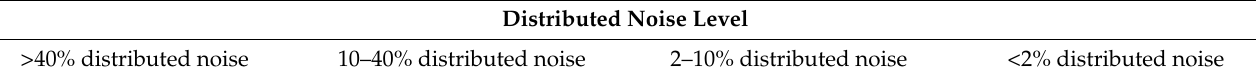
Table 14. Acoustic Quality TABS: Distributed noise level.